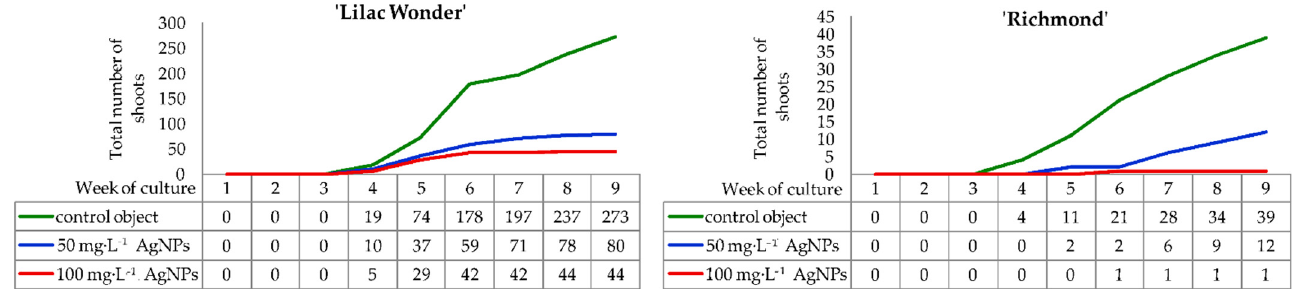
Figure 1. Dynamics of adventitious shoots regeneration on the inoculated Chrysanthemum × grandiflorum ‘Lilac Wonder’ and ‘Richmond’ leaf explants cultured on the modified MS medium with 0.6 mg · L − 1 BAP and 2 mg · L − 1 IAA, depending on the AgNPs treatment (0–100 mg · L − 1 ).